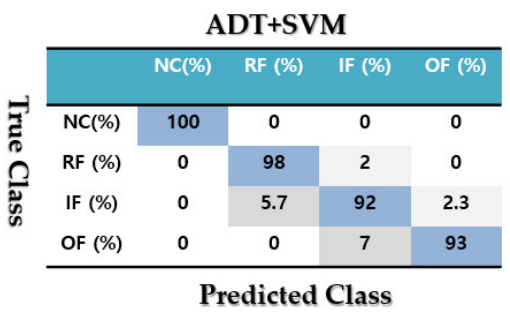
Figure 6. The RMS resampled residual signals using the proposed ADT algorithm: (I) for the NC, RF, IF, and OF and (II) zoom view.